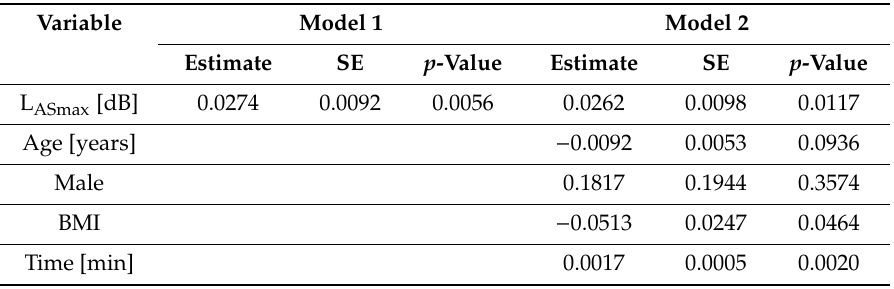
Table 5. Random e ff ect logistic regression models for the probability of awakening.